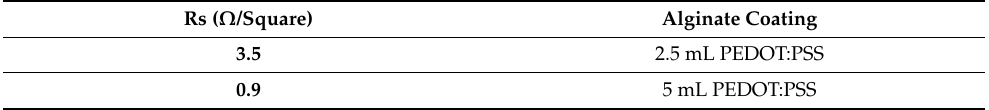
Table 2. Sheet resistance of (A/P:P) at different concentrations of